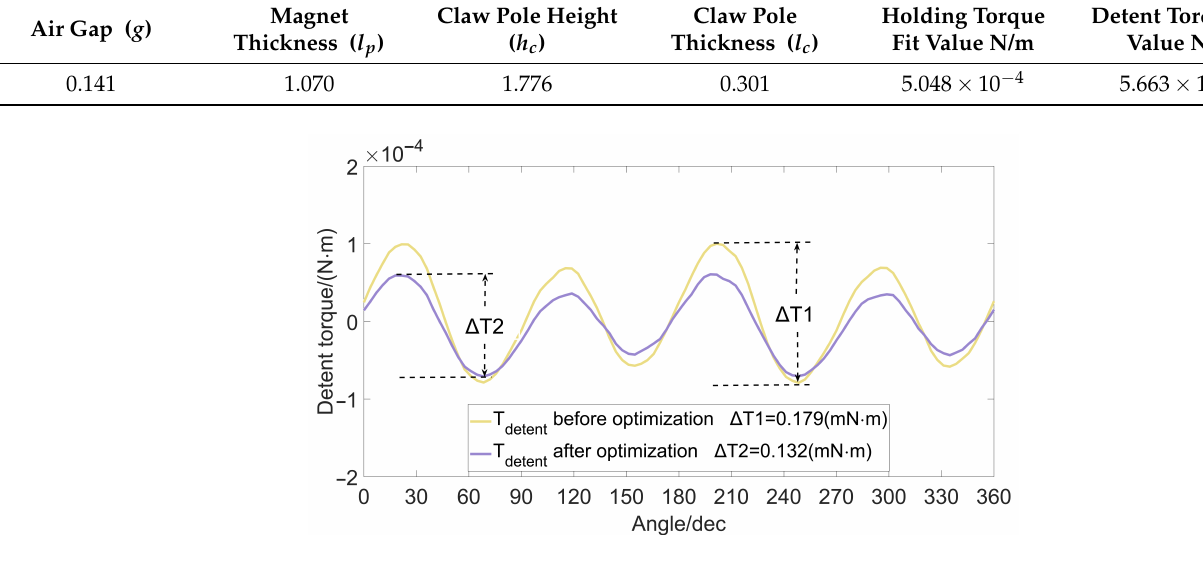
Figure 6. Comparison of detent torque.